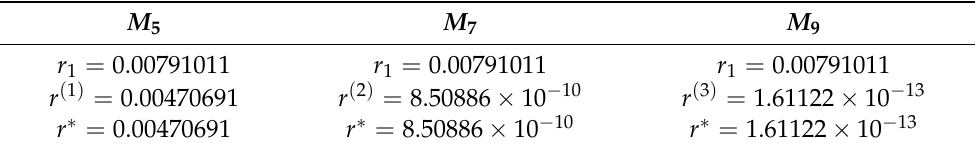
Table 1. Numerical results for example